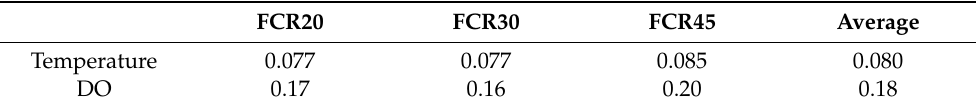
Table 8. The NMAEs of the temperature and DO of the 3-D model at FCR20, FCR30 and FCR45 for the 2014